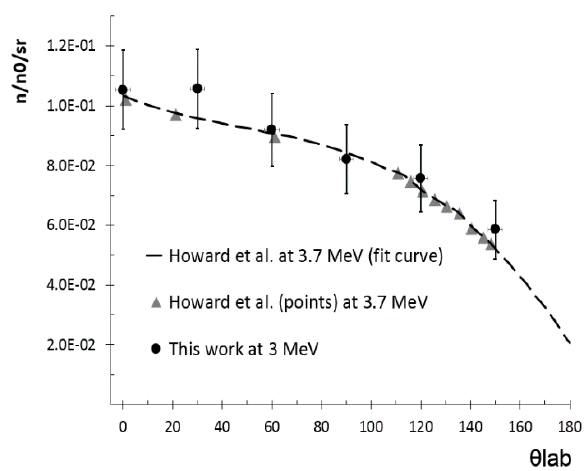
Fig. 5. Angular distributions of the neutrons from the 9 Be (p,n) reaction of 3 MeV proton beam compared with the results of Howard et al. [15] at 3.7 MeV. The angular resolution was ±2.8º.